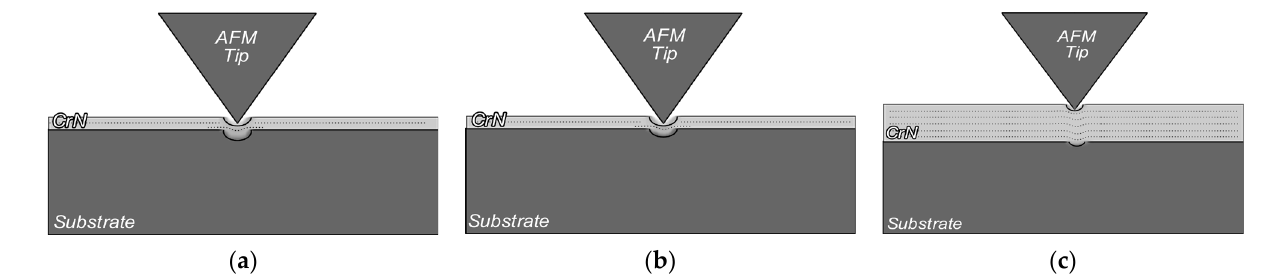
Figure 13. Mechanical explanations of the tip sample interaction when using HiPIMS power supply for the deposition times of ( a ) 5 min, ( b ) 10 min and ( c ) 15 min.